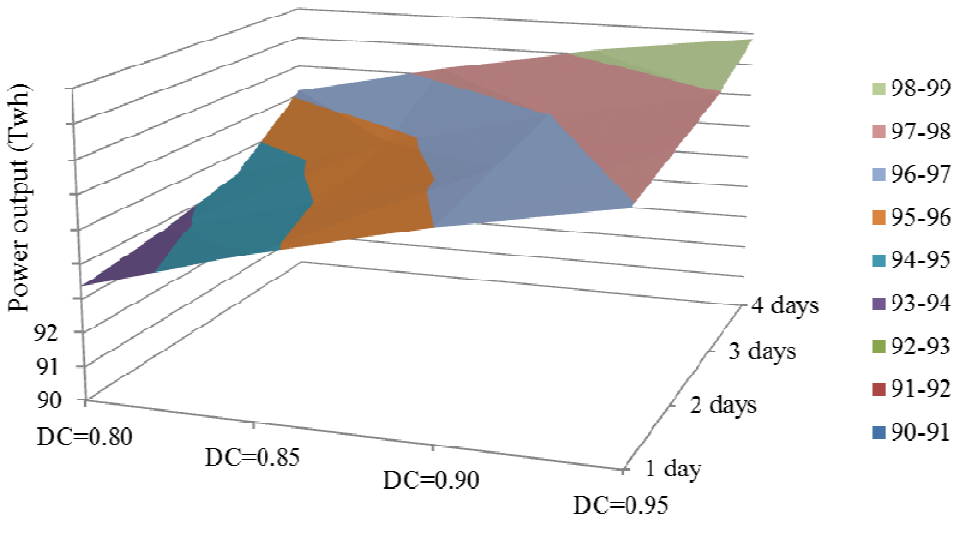
Figure 3. Relationship between different forecast accuracy, forecast time, and power